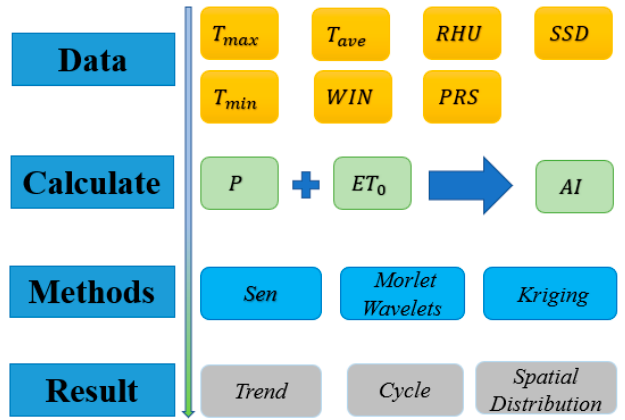
Figure 2 . Research Framework Diagram. Figure 2. Research Framework